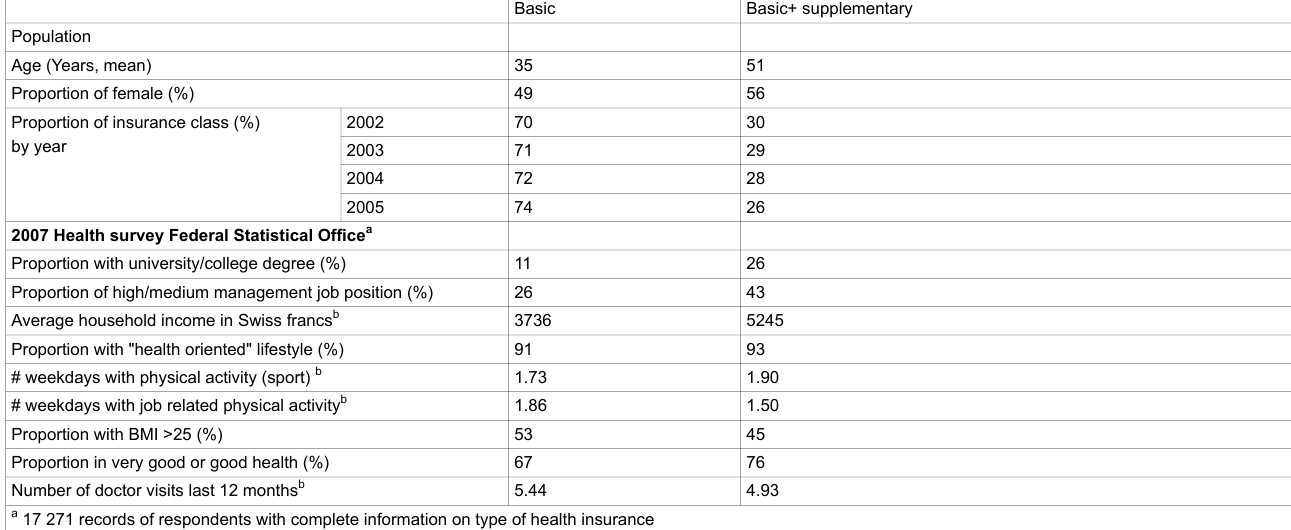
Table 1: Sociodemographic characteristics of the Swiss population classified by class of insurance (2002–2005).